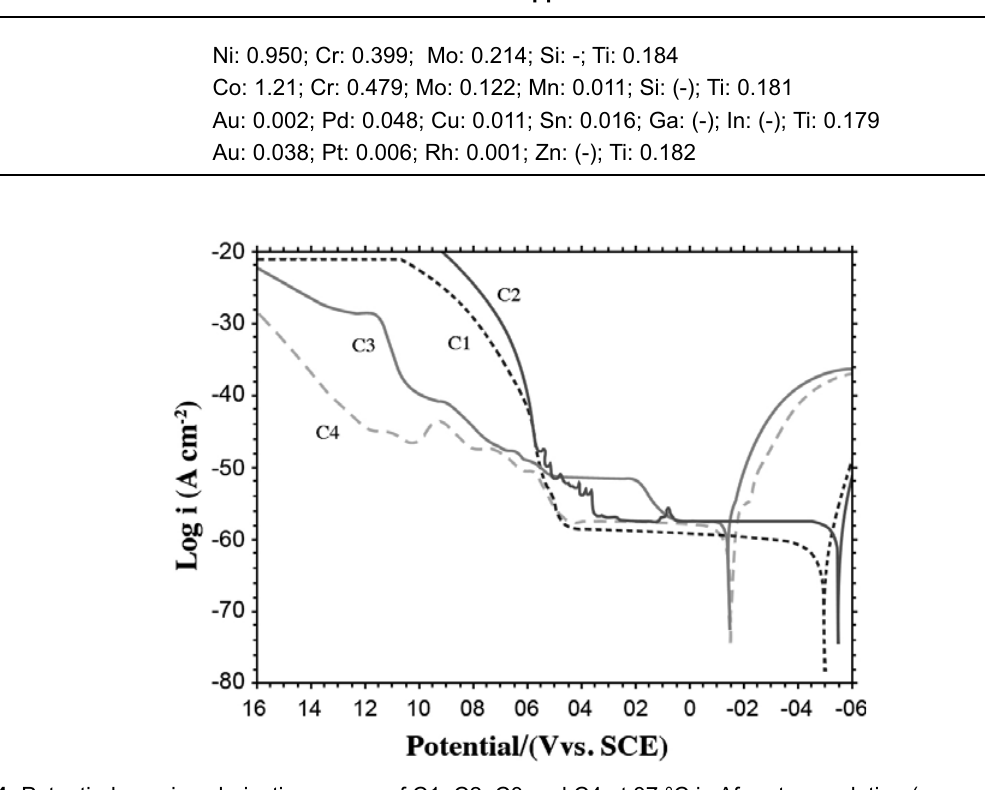
TABLE 4- Concentration of the ions leached into the artificial saliva solutions from the Ti/suprastructure couples Sample